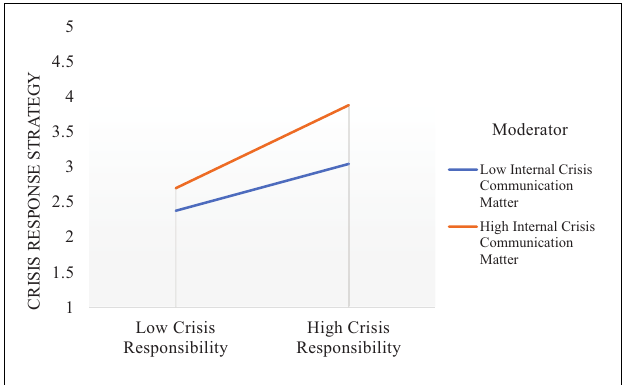
FIGURE 4 | Moderation